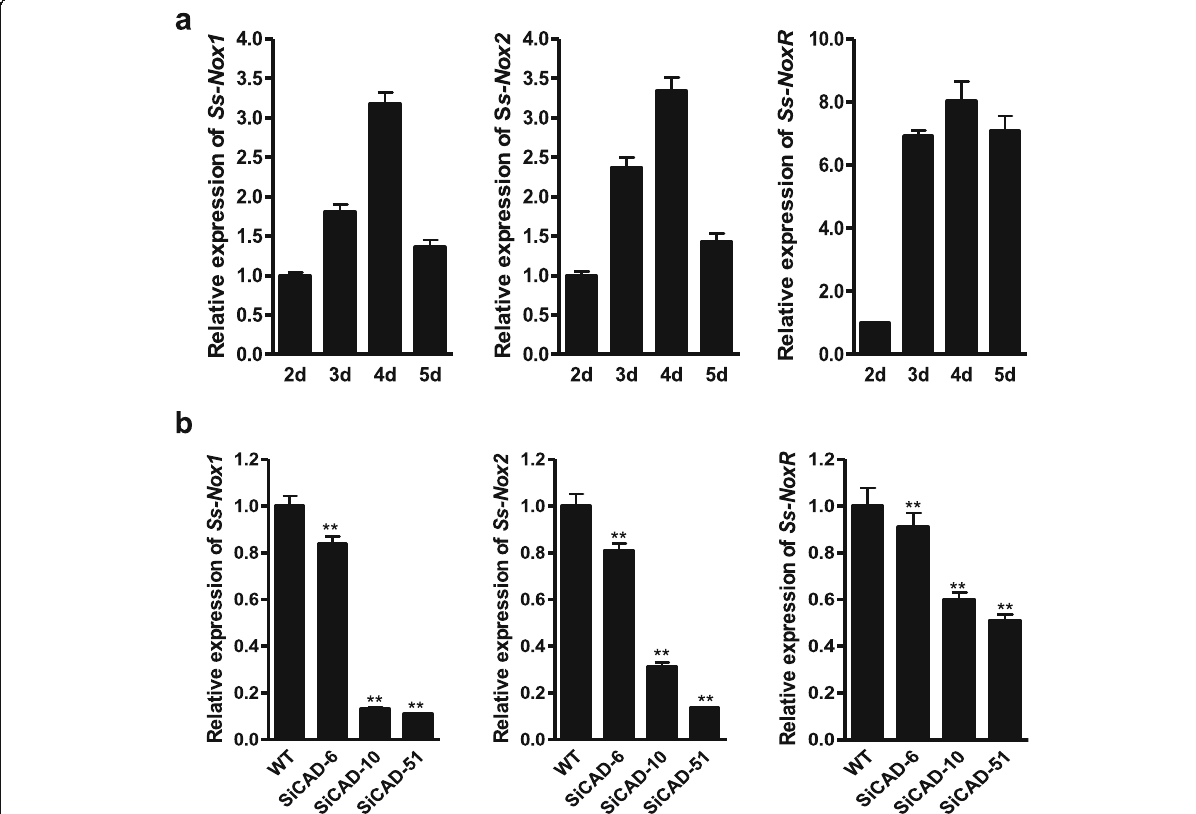
Fig. 4 Expression levels of Ss-Nox1 (GenBank accession No. XP_001592740), Ss-Nox2 (GenBank accession No. XP_001587930), and Ss-NoxR (GenBank accession No. XP_001598015) in the wild-type strain EP-1PNA367 and Ss-CAD -silenced transformants. a qRT-PCR analysis of Ss-Nox1 , Ss- Nox2, and Ss-NoxR transcript levels at different sclerotial development stages in the wild-type strain. b qRT-PCR analysis of Ss-Nox1 , Ss-Nox2, and Ss-NoxR transcript levels in Ss-CAD -silenced transformants. Ss-Nox1 , Ss-Nox2, and Ss-NoxR cDNA expression levels were measured using qRT-PCR and were normalized to actin cDNA. Three independent replicates were performed for each experiment. Values are means ± S.E. ** P < 0.01; one-way